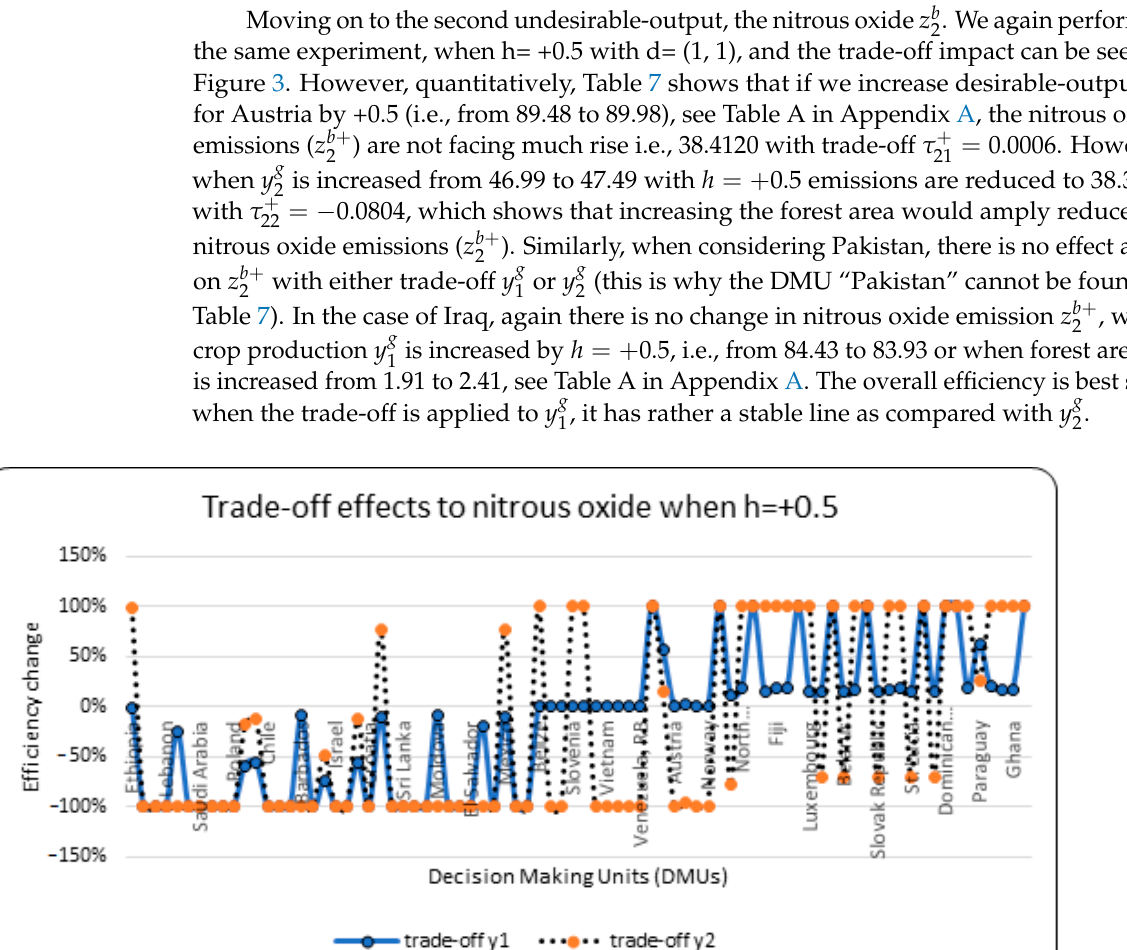
Figure 3. Trade-off effects on the nitrous oxide emissions ( z b ), when h = +0.5. 2 Next, we look for the effects on nitrous oxide emissions ( z b ) in Table 8, when the trade- 2 off is applied to y g and y g with h = − 0.5. Again, if we trade-off Austria’s y g with h = − 0.5. 2 1 1 = − 0.0006, but i.e., from 49.48 to 48.98, the z b − decreases to 38.4108 with trade-off rate τ − 2 21